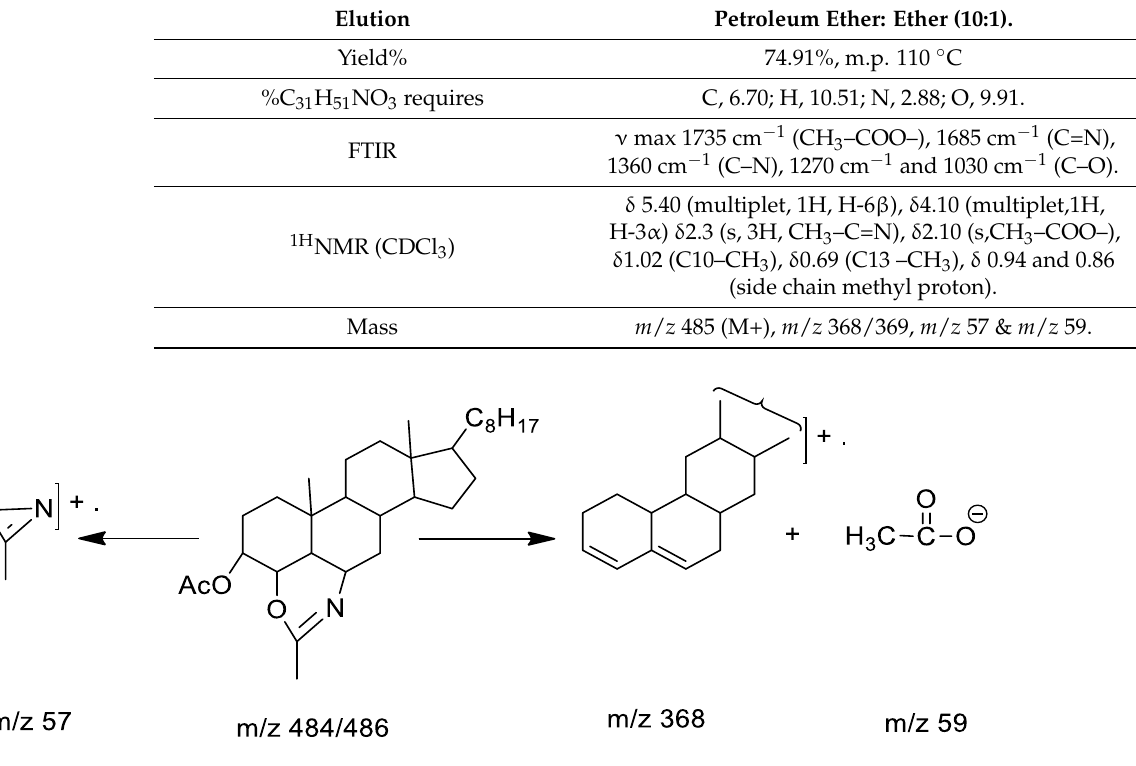
Table 3. FTIR, 1HNMR and mass analyses of 3β -chloro-N-amido- 5α -cholestano-aziridine ( VII ).